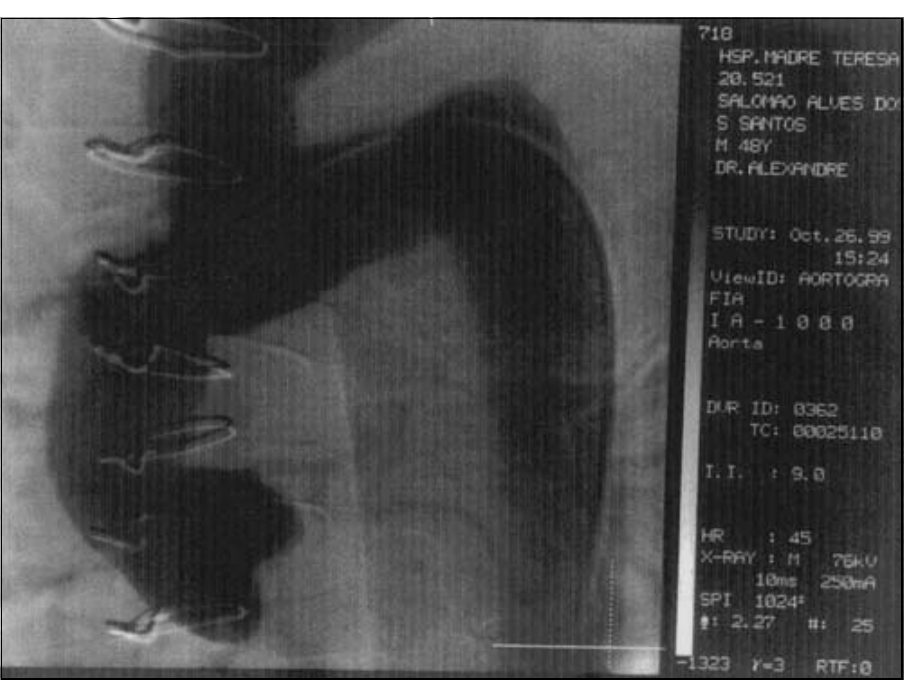
segmento (na presente casu(cid:237)stica este segmento foi abordado somente em 12,5% dos pacientes). A mortalidade foi de 10,3%, sendo que todos os casos foi conseq(cid:252)ente (cid:224) s(cid:237)ndrome da resposta inflamat(cid:243)- ria sistŒmica (SARA/ insuficiŒncia renal aguda, etc). O emprego do anel intraluminal proporcionou uma anastomose rÆpida e tecnicamente fÆcil. Nos casos em que nªo utilizamos sutura convencional